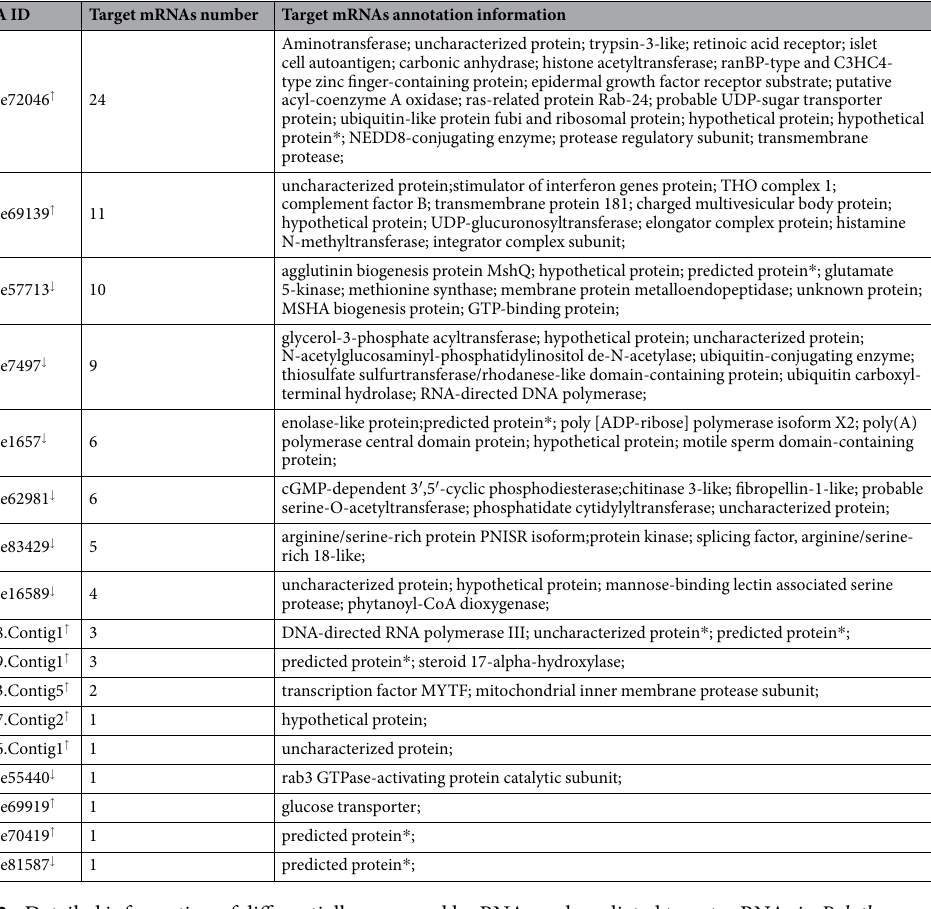
Table 2. Detailed information of differentially expressed lncRNAs and predicted target mRNAs in Palythoa caribaeorum . * Represents protein uniquely annotated in cnidarian, i.e., Nematostella vectensis, Hydra vulgaris. ↑ Represents up-regulated in Bleaching P . caribaeorum versus Healthy P . caribaeorum . ↓ Represents down- regulated in Bleaching P . caribaeorum versus Healthy P . caribaeorum